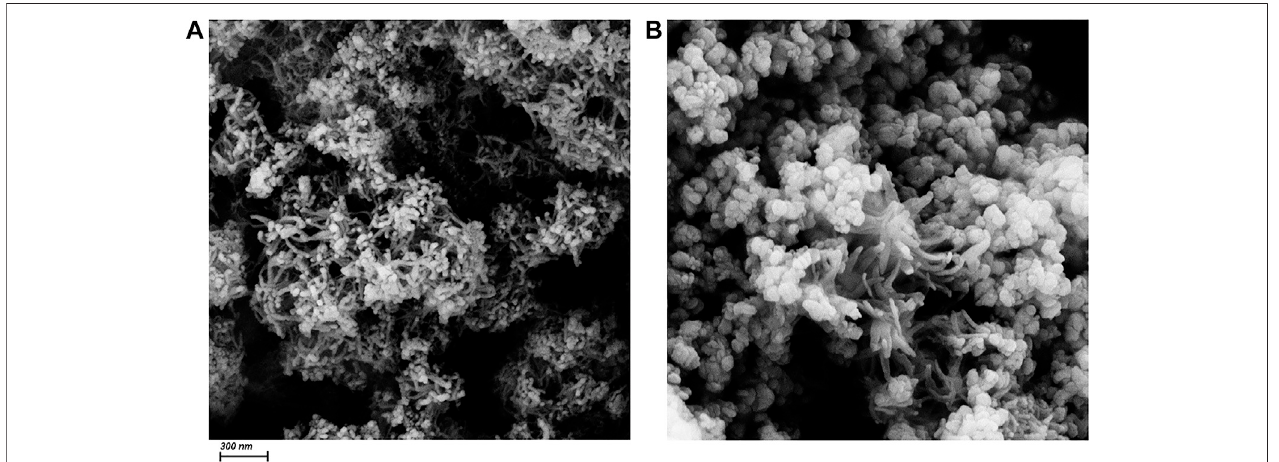
FIGURE 3 | The SEM images of CuO nanowires (A) and CuO/Cu 2 O/Cu nanocomposites (B) . The scale bar is 300 nm.